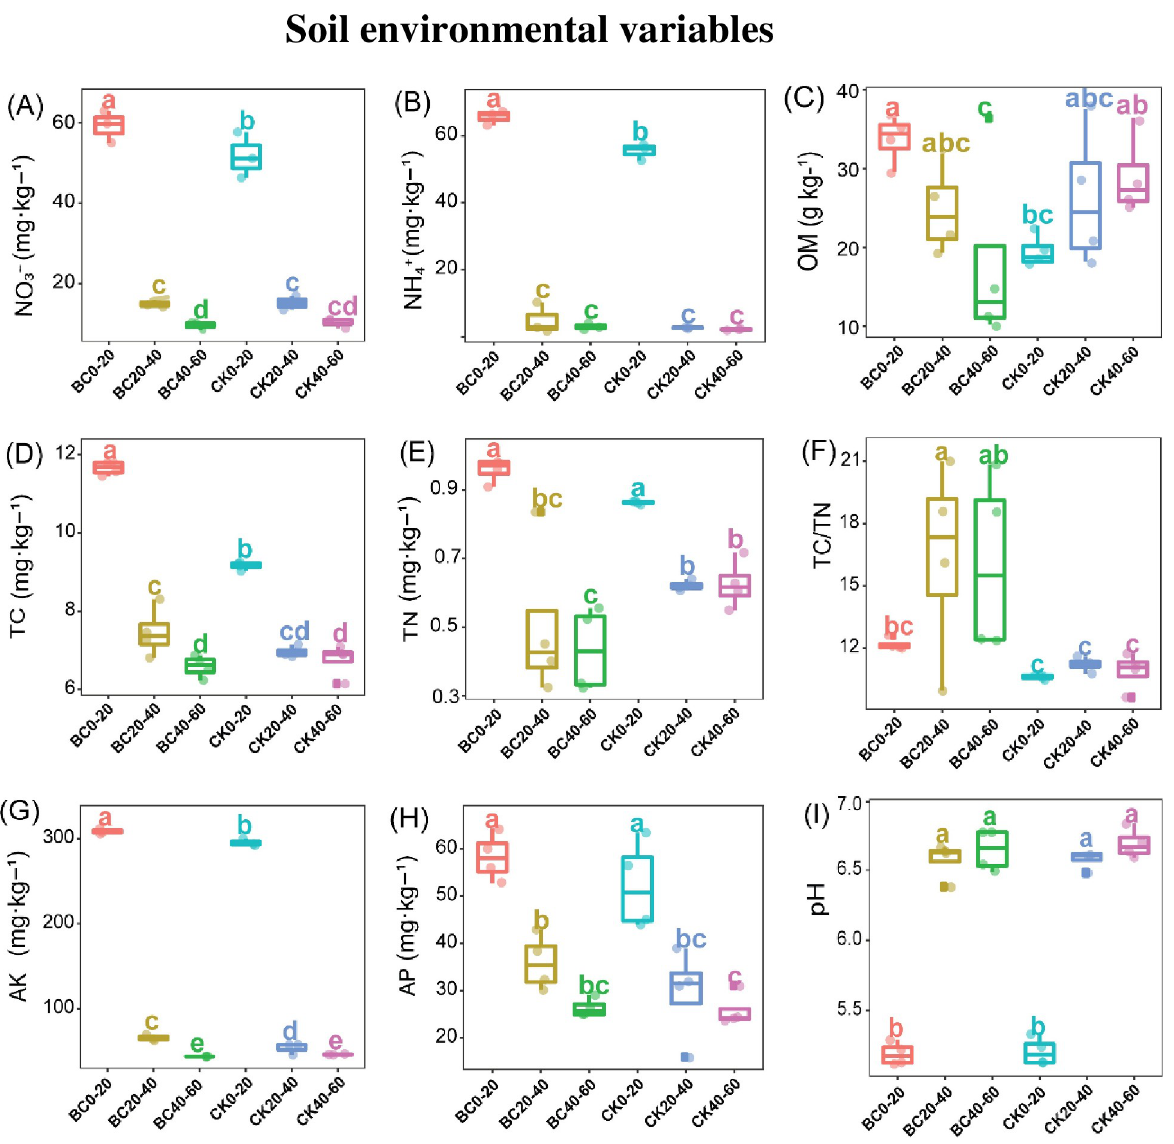
Fig 2. Soil environmental variables at three soil layers under biochar (BC) amended soil compared to control (CK). Boxplots with different lowercase letters depict significant differences between treatments (Tukey test, p < 0.05). (A) NH 4+ , ammonium; (B) NO 3 -, nitrate; (C) OM, soil organic matter; (D) TC, total soil carbon; (E) TN, total nitrogen; (F) TC/TN, carbon/nitrogen ratio; (G) AK, available potassium; (H) AP, available phosphorus; (I) pH potential